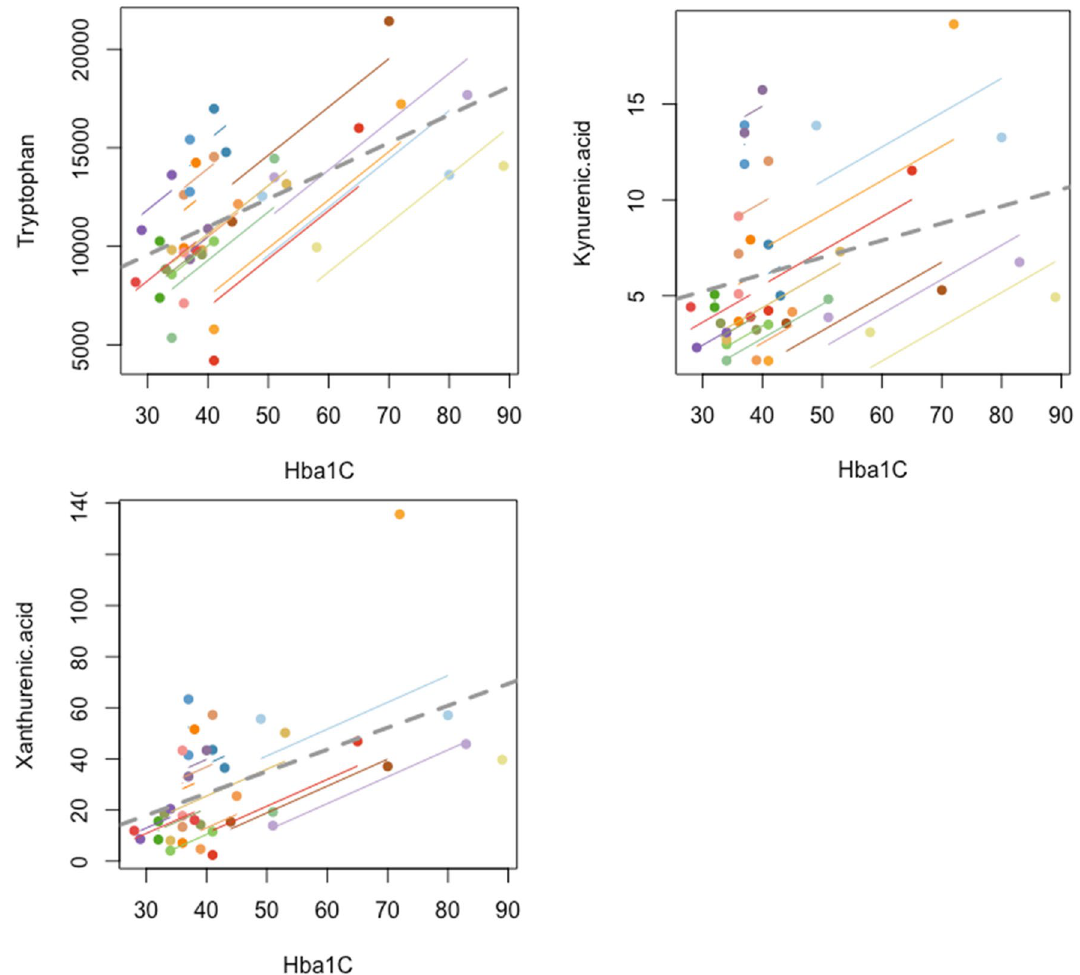
Figure 6. Repeated measure correlation plots of HbA1c with tryptophan, kynurenic acid and xanthurenic acid levels respectively.Metabolite units (ng/ml), HbA1c